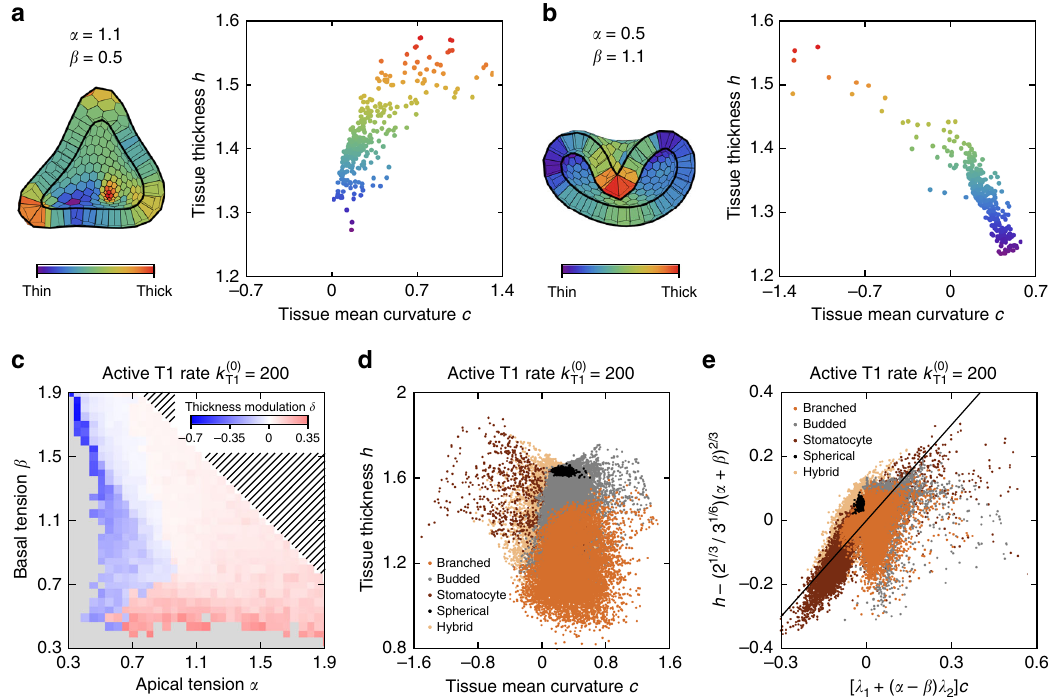
¼ 200) budded shape T 1